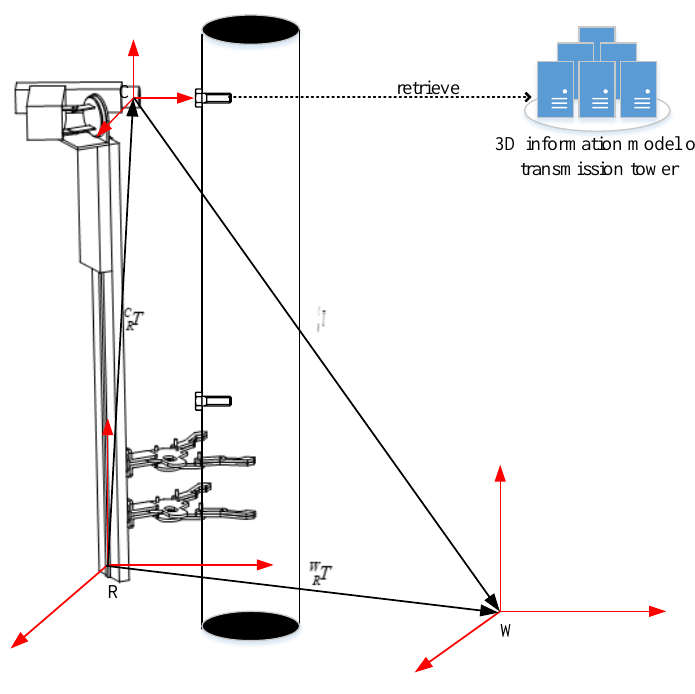
Figure 4. Schematic diagram of the robot pose